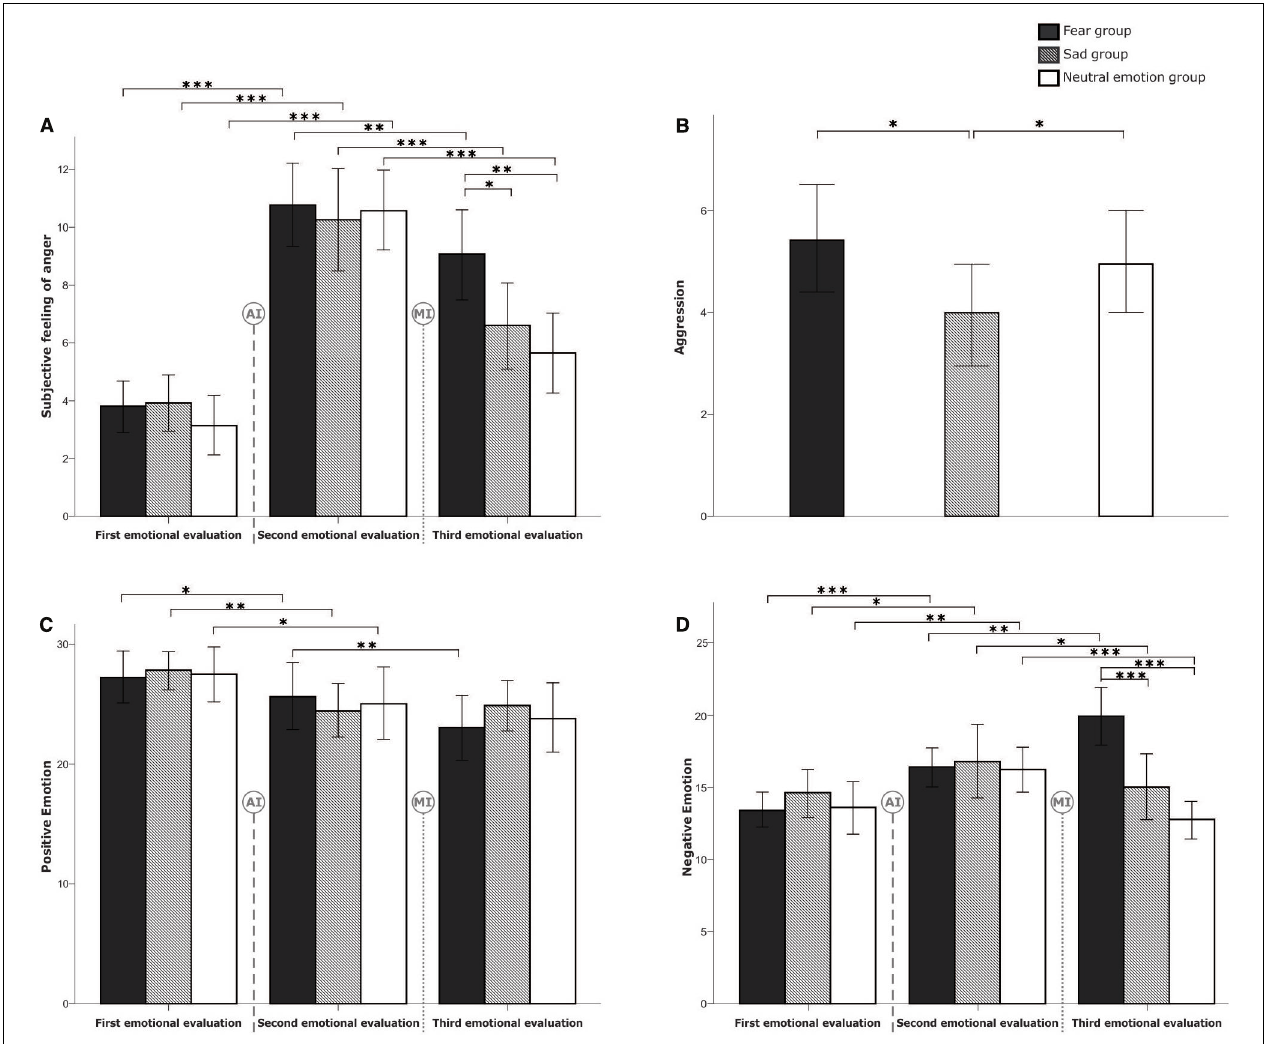
FIGURE 3 | Comparisons of emotional change and the level of aggressive behavior among the three experimental conditions in Study 1. Participants’ subjective feelings of anger, positive emotion, and negative emotion in the three experimental stages (i.e., first emotional evaluation, which was administered before anger induction; second emotional evaluation, which was administered after anger induction; and third emotional evaluation, which was administered